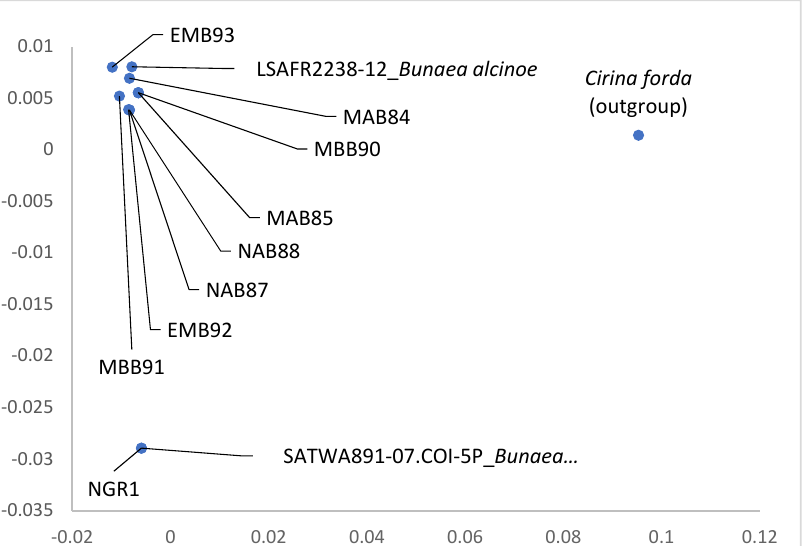
Figure 5. The principle coordinate analysis of COI gene of morphotypes of Bunaea alcinoe from Kenya and Nigeria. The first two letters indicate the collection sites (NG = Nigeria, MB = Mbita, EM = Embu, NA = Nanyuki and MA = Matuu). The last letter depicts the color of the larvae (R = red and B = black). The number indicates sample ID. SATWA891-07.COI-5P (BIN BOLD:AAA6756) and LSAFR2238-12 (BIN BOLD:AAA6757) are BOLD reference accession numbers.